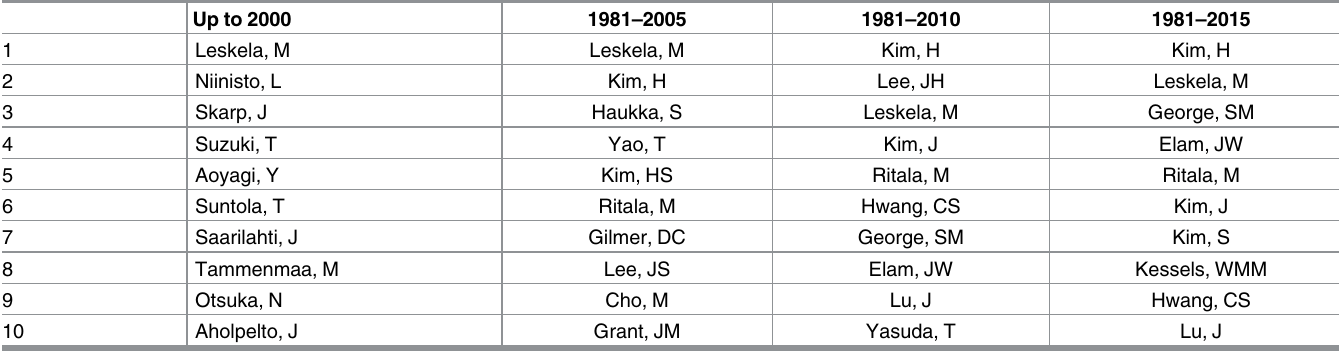
Table 7. Top 10 authors a based on betweenesscentrality.